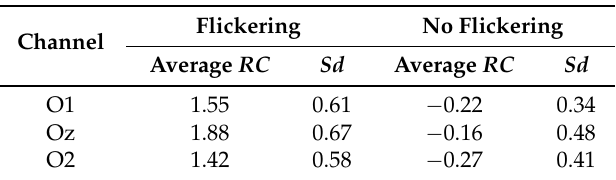
Table 2. Average relative charge ( RC ) values and standard deviations ( Sd ) of five subjects under flickering and no flickering conditions.